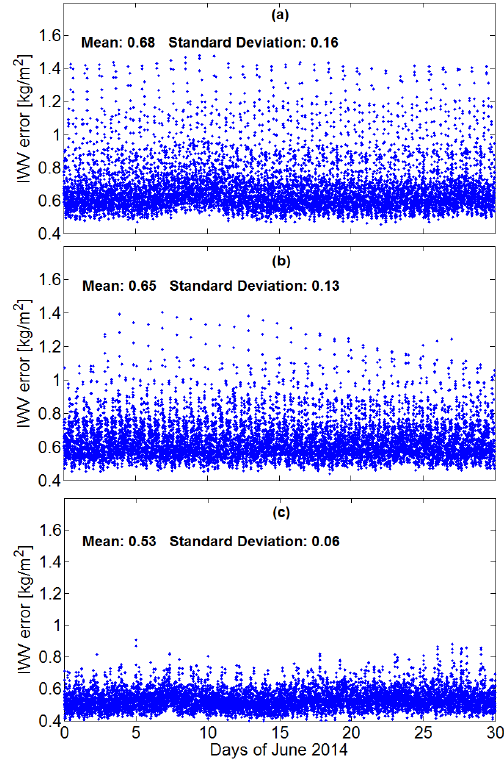
Figure 9. The estimated total IWV uncertainty for the month of June 2014 and for three GRUAN sites: (a) LDB0, (b) LDRZ, and (c)